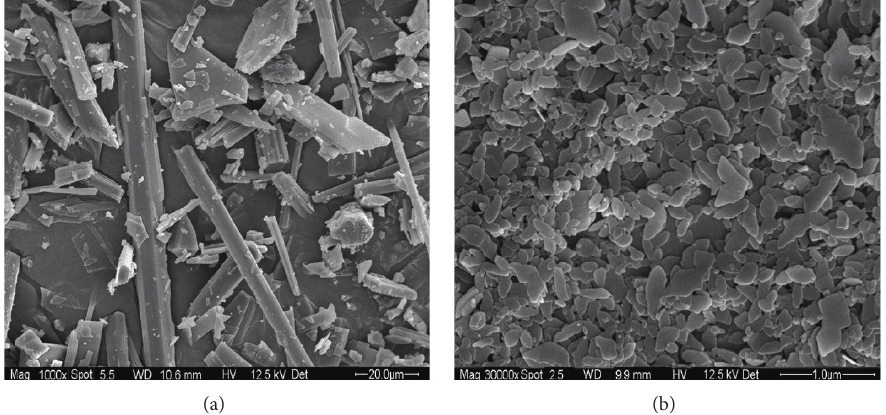
Figure 4: Scanning electron micrographs of r-Res (a) and u-Res